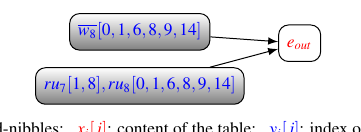
Figure 11: Construction of Table T 7 on the 10-round